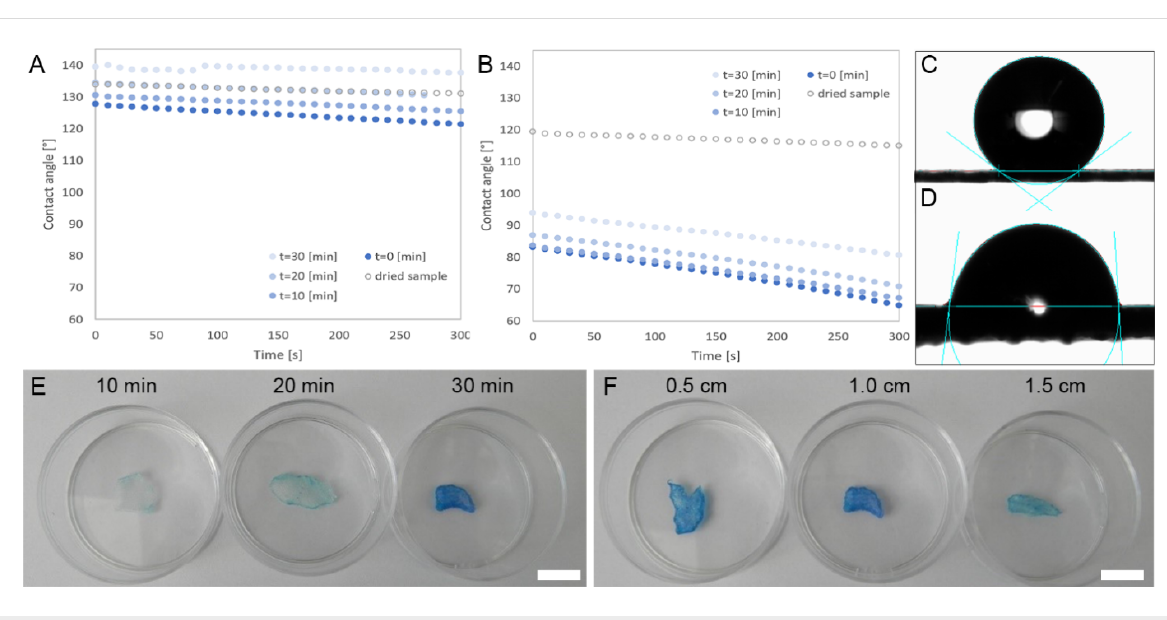
Figure 1: A) Graph showing change in the static contact angle with time on a pristine PCL scaffold with a 500 µm hatch spacing and B) on a SIPGP- coated scaffold with a 500 µm hatch spacing. The measured samples were immersed in water for different periods of time t = 0, 10, 20, 30 [min]. C) Photograph of a 2 µL water drop on a pristine PCL scaffold immediately after droplet deposition and D) on a SIPGP-modified scaffold immediately after droplet deposition. E and F) toluidine blue staining of PCL scaffolds coated with PHEMA via SIPGP showing the variation with E) the UV-reac- tion time and F) the distance between light source and substrate. Scale bar for E and F is 1